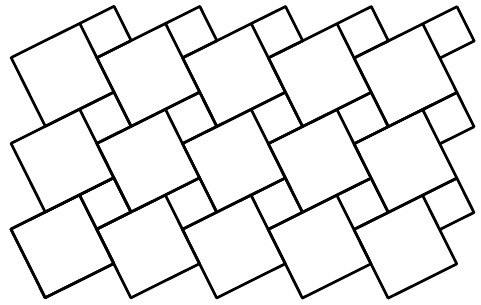
Fig. 57: Tiling with two types of squares